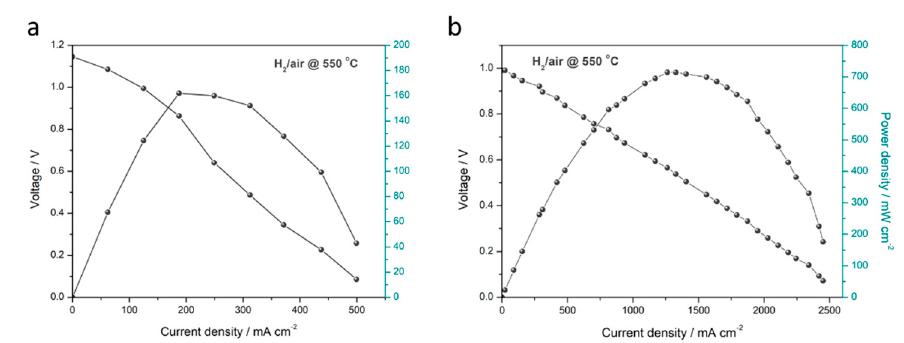
Figure 6. I–V and I–P characteristic of ( a ) the conventional SOFC using LCF as cathode and ( b ) the SBFC device using LCF as semiconductor membrane layer.